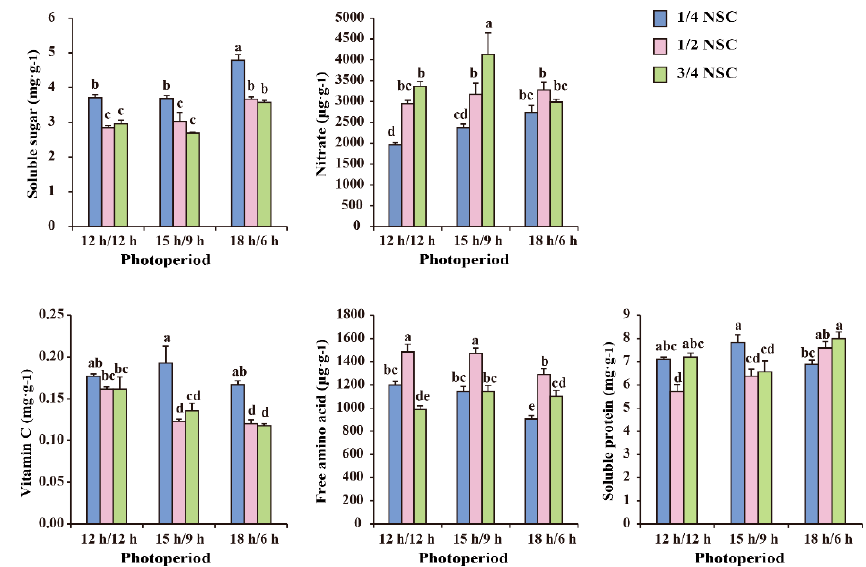
Figure 1. Soluble sugar, nitrate, vitamin C, soluble protein, and free amino acid contents in lettuce under the interaction of photoperiod and NSC. The letters marked in all figures mean the significance of differences ( p ≤ 0.05, Tukey’s test).